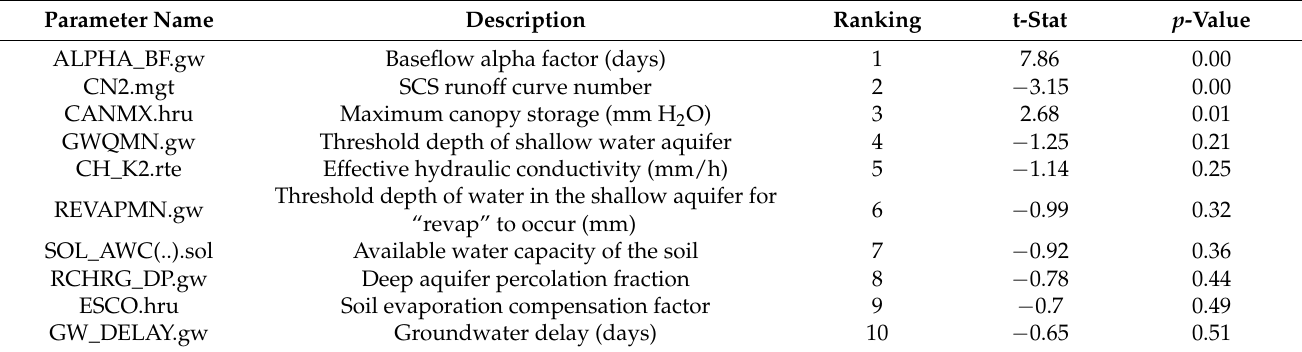
Table 8. Identified sensitive flow parameters of the study